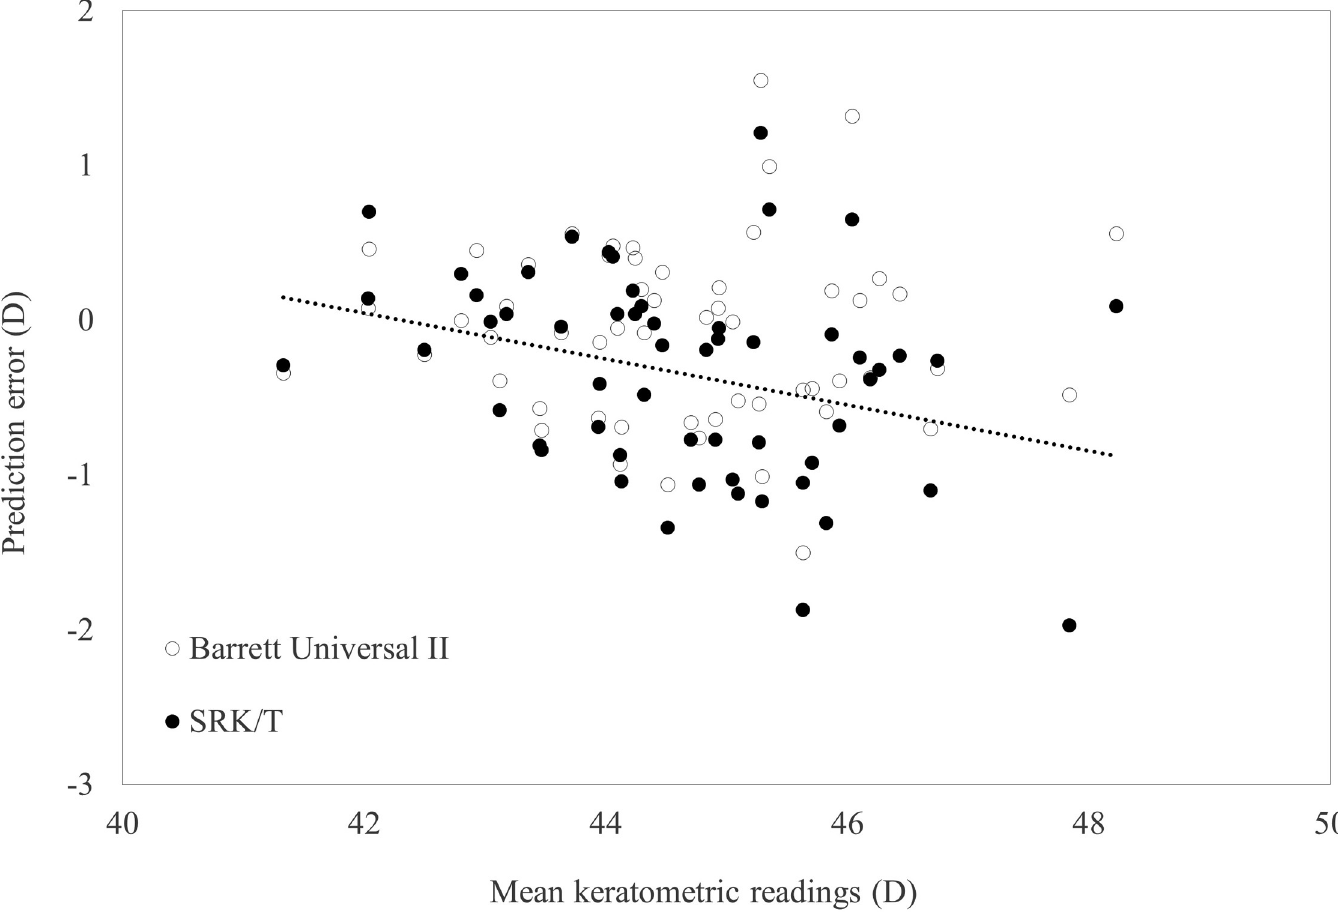
Fig 4. A graph showing correlations between the prediction error and the mean keratometry (Pearson correlation coefficient, r = -0.023, p = 0.870 for the Barrett Universal II formula, r = -0.317, p = 0.017 for the SRK/T formula).